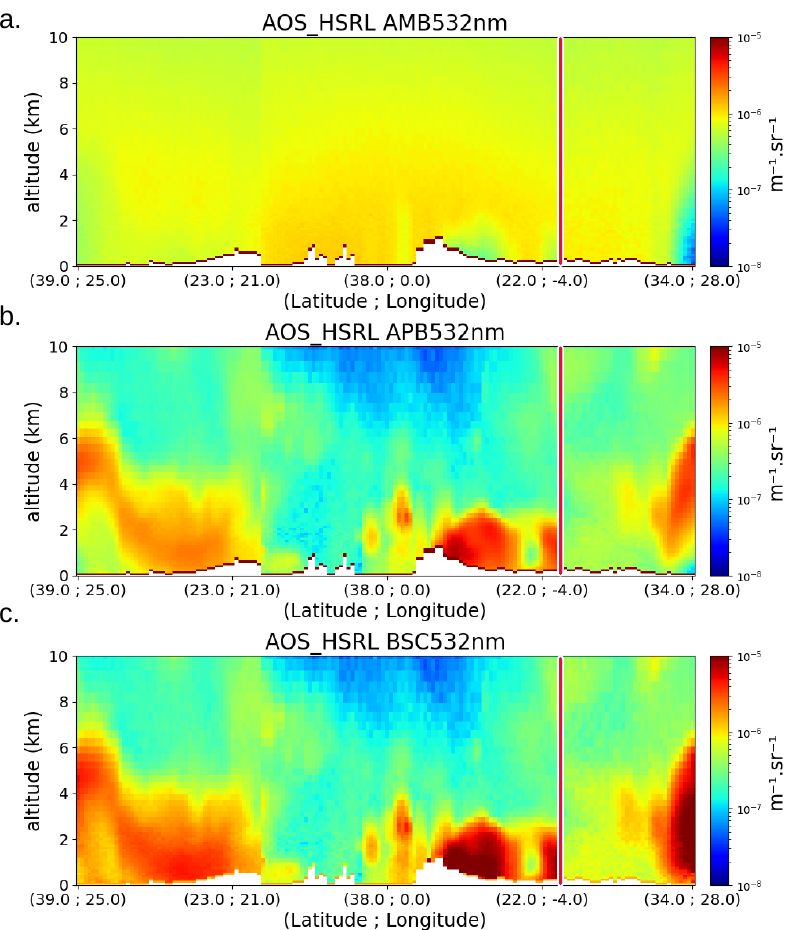
Figure 6. AOS_Like SO in terms of AMB, APB, and the particular coefficient backscatter at 532 nm along the trajectory of CALIOP for 22 March 2018 over the Medit region. ( a ) Transect of AMB ( b ) Transect of APB, and ( c ) transect of synthetic particular backscatter coefficient. The vertical red line corresponds to the start of the daytime orbit